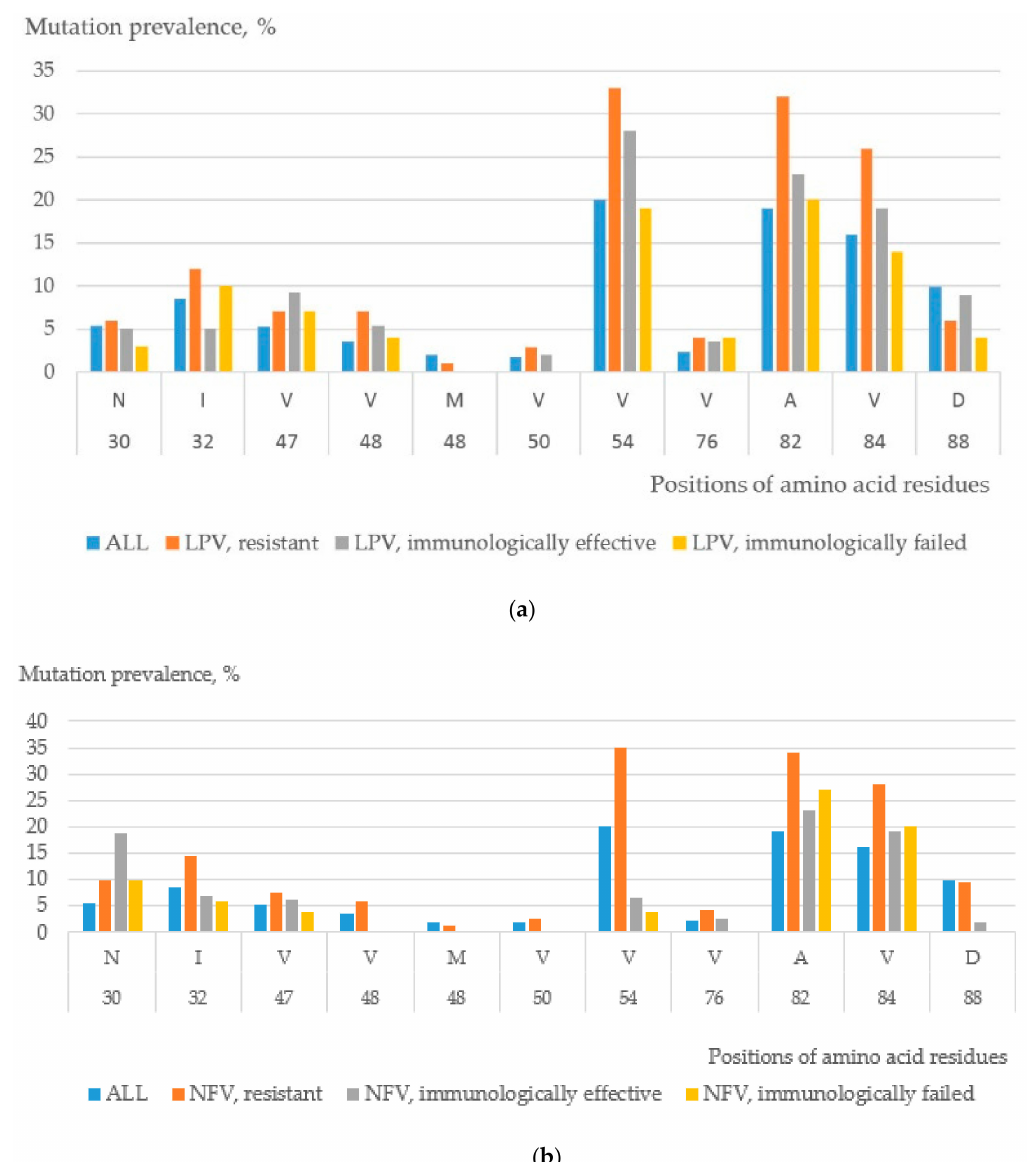
Figure 2. Distribution of amino acid mutations in HIV-1 protease for the whole set of isolates, a subset of resistant isolates, and isolates for which antiretroviral therapy was characterized as immunologically e ff ective and failed for ( a ) LPV and ( b ) NFV. One letter codes with positions of the major drug resistance mutations are shown on the horizontal axis. N, asparagine; I, Isoleucine; V, Valine; M, Methionine; A, Alanine; and D, aspartic